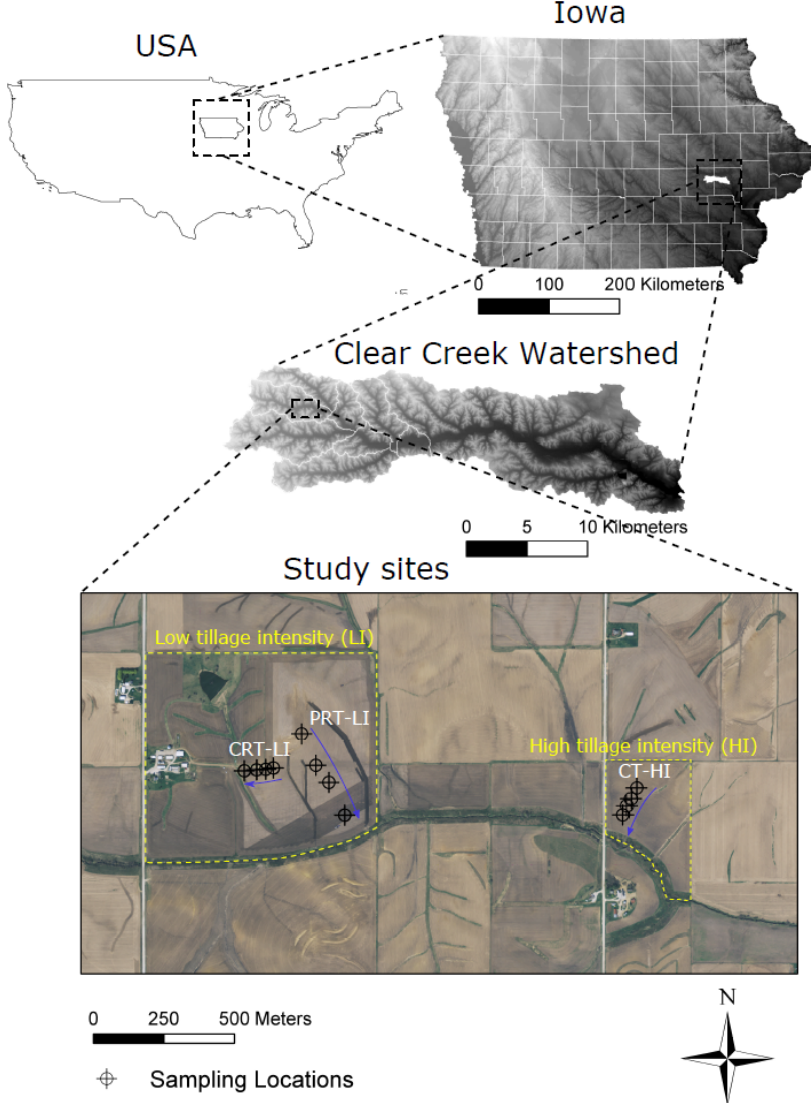
Figure 2. Study sites in representative intensively managed agricultural fields of Clear Creek Watershed, IA. Management treatments include Contour Ridge Tillage-Low Intensity (CRT-LI), Parallel Ridge Tillage-Low Intensity (PRT-LI), and Contour Tillage-High Intensity (CT-HI).